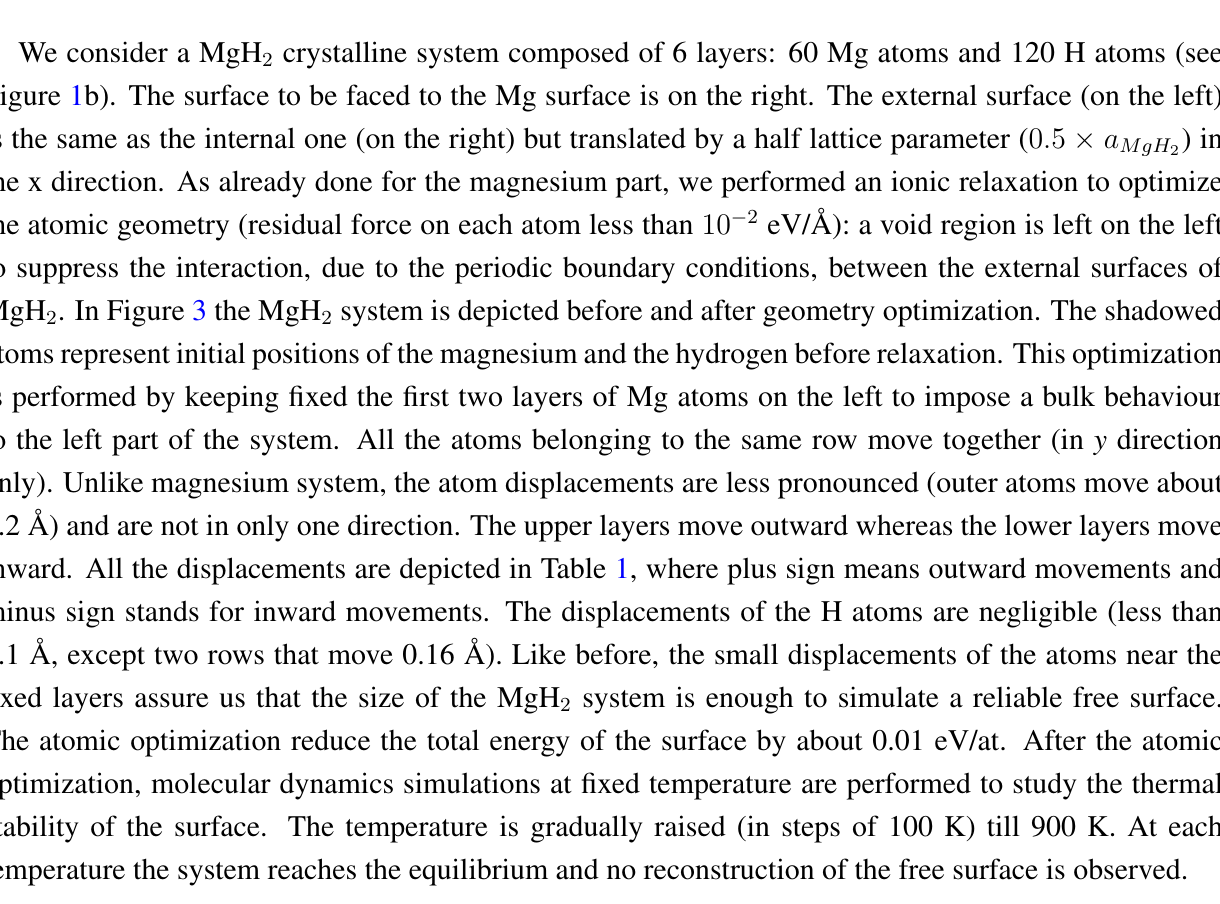
Figure 3. Magnesium hydride free surface before and after geometry optimization. The shadowed atoms represent initial positions of atoms before relaxation. In parenthesis are shown distances in ˚A between initial and final positions of the Mg rows (see also Table 1). We indicated with Hr , Hr , Hr , and Hr , four groups of H atoms closer to the interface a b c d (see Section